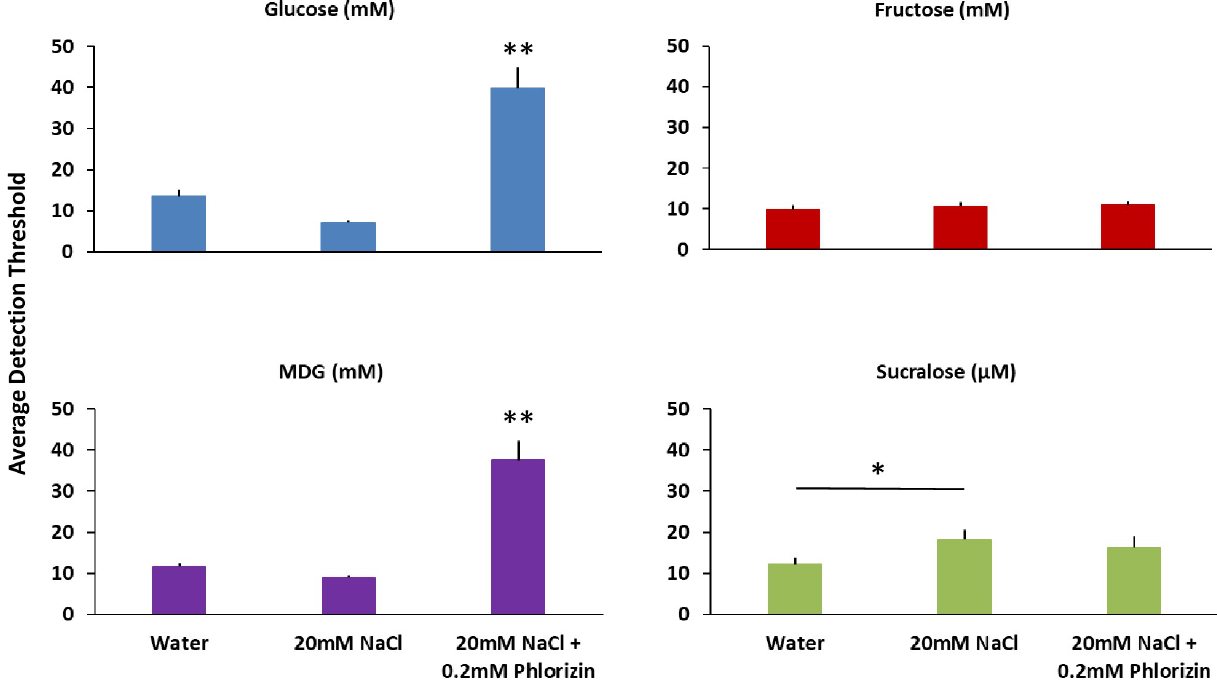
Fig 4. Impact of phlorizin on glucose, fructose, MDG and sucralose detection thresholds. There are four bar charts in Fig 4. The chart with the blue bars show average detection thresholds for glucose in mM. The chart with the red bars show average detection thresholds for fructose in mM. The chart with the purple bars show average detection thresholds for MDG in mM. The chart with the green bars show average detection thresholds for sucralose in μ M. Each chart contains three bars. From left to right the bars show: 1) Detection threshold, 2) Detection threshold with 20mM NaCl added, 3) Detection threshold with 20mM NaCl and 0.2mM phlorizin added. All treatments were paired with water rinses between stimuli. Twelve subjects participated in the fructose and sucralose testing and eleven subjects participated in the glucose and MDG testing. All subjects completed two replications. Error bars are standard errors of the mean. � indicates a significant difference, p < .05, �� indicates a significant difference p < .001.